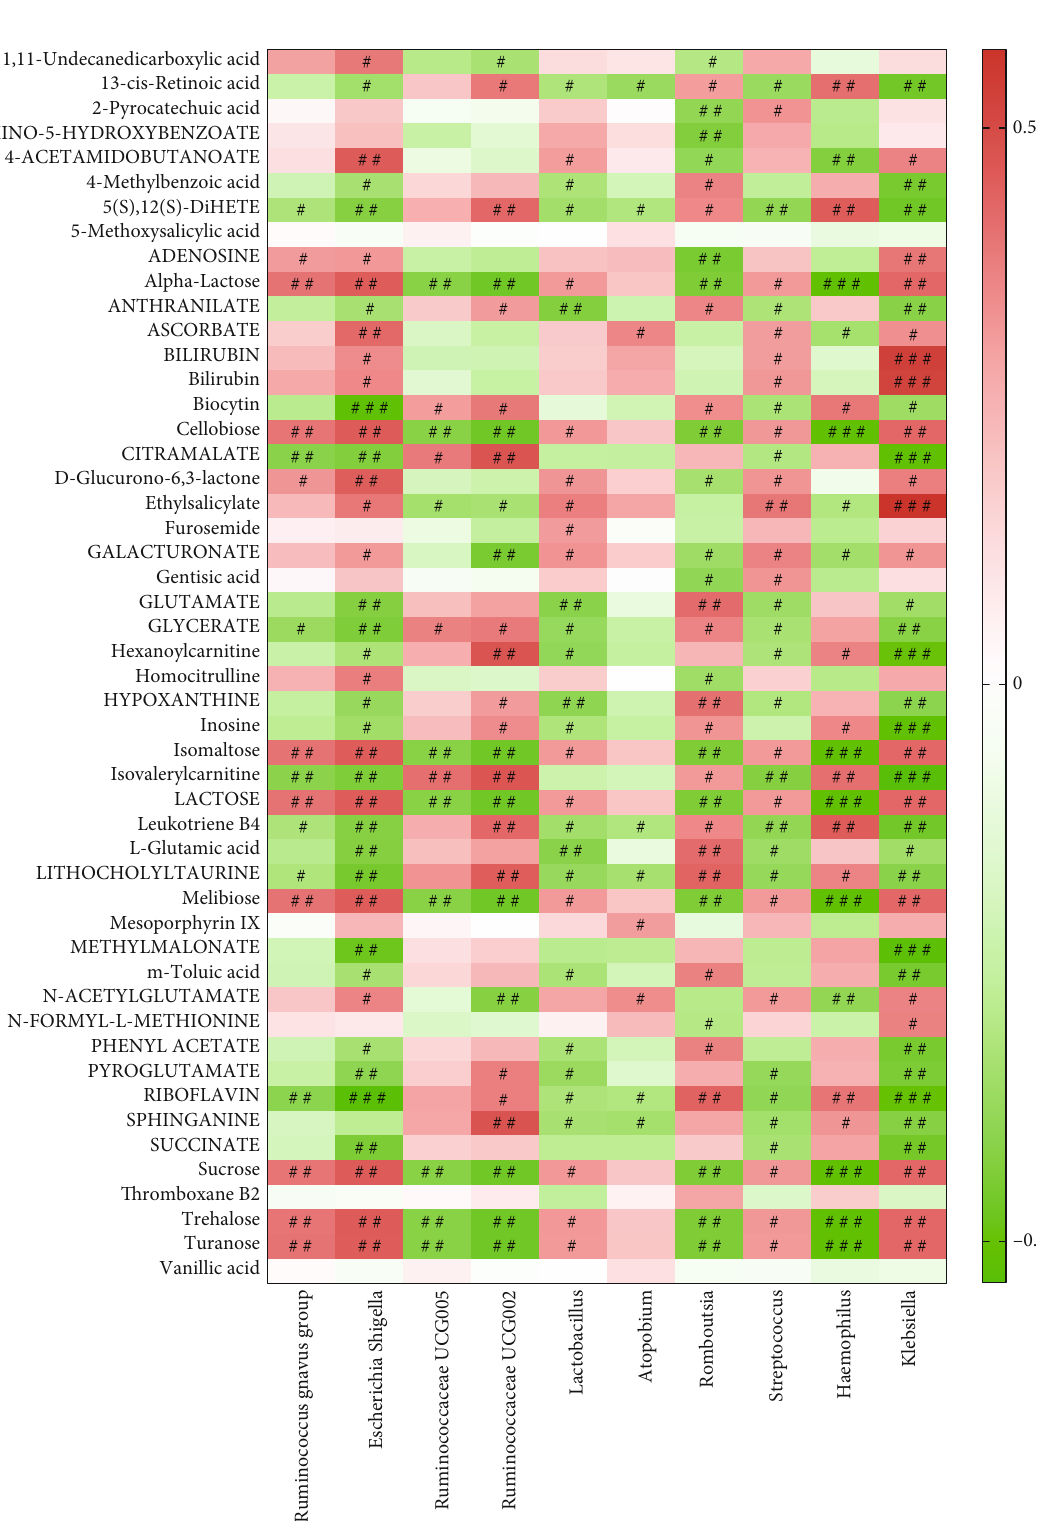
Figure 6: The correlation between gut microbiota and serum metabolomic. Red represents positive correlation, and green represents negative correlation. # P < 0 : 05 ; ## P < 0 : 01 ; ### P < 0 : 001